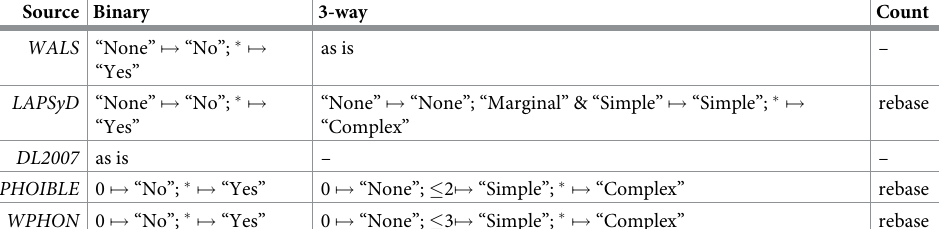
Table 5. How I coded tone for each data source. The given rules are of the form original value(s) 7! coded value ; � means “all other original value(s)”; “as is” means the value as given by the data source without change; “rebase” applies only to the counts (see text for details); “–” means that the data source did not contribute to the coding (does not con- tain useful information). Source Binary 3-way Count as is – WALS “None” 7! “No”; � 7! “Yes” “None” 7! “None”; “Marginal” & “Simple” 7! “Simple”; � 7! LAPSyD “None” 7! “No”; � 7! “Yes” “Complex” DL2007 as is – – PHOIBLE 0 7! “No”; � 7! “Yes” 0 7! “None”; � 2 7! “Simple”; � 7! “Complex” rebase WPHON 0 7! “No”; � 7!